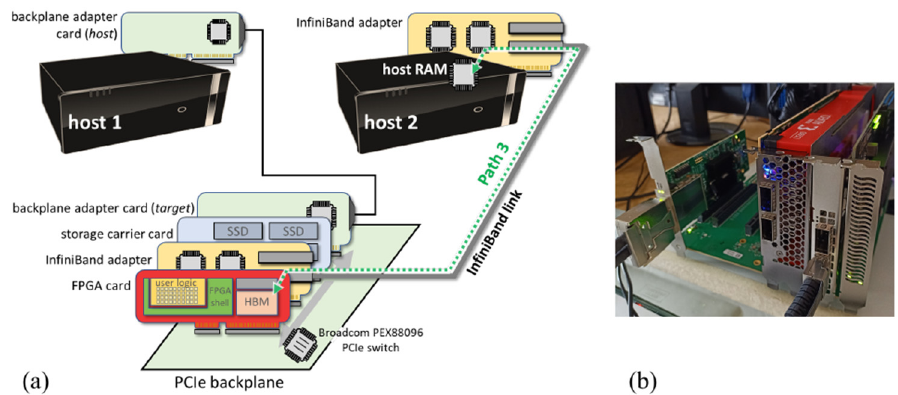
Figure 2. ( a ) Schematic of the backplane-based system. The dashed arrow indicates the communi- cation path exercised in our experimental evaluation. ( b ) Photograph of the system.